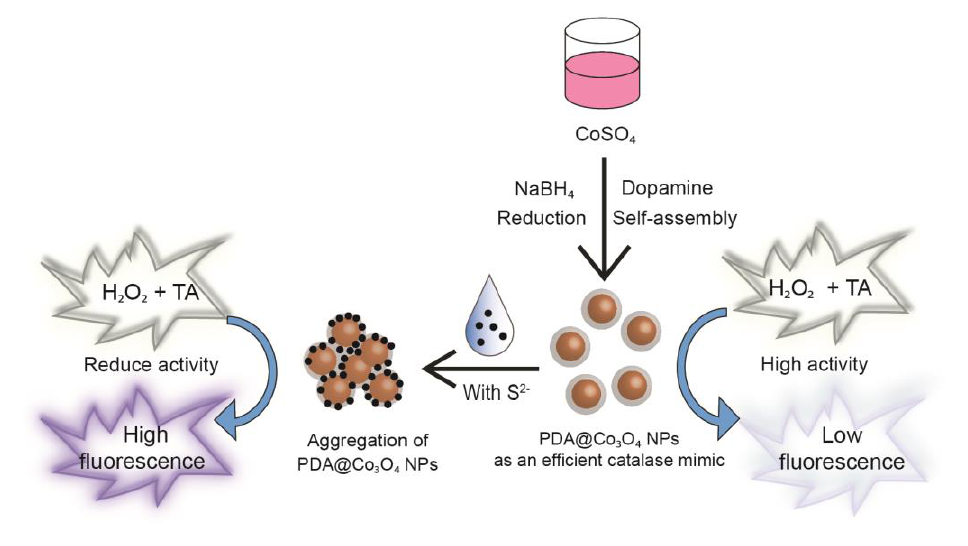
Figure 1. Schematic illustration of the synthesis of catalase-like PDA@Co 3 O 4 NPs and their applica- tion to fluorescently detect sulfide ion (S 2 − ). tion to fluorescently detect sulfide ion (S 2 −